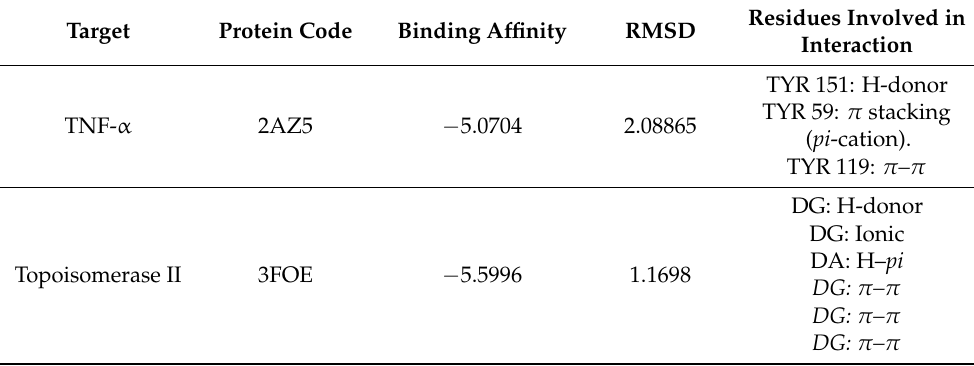
Table 1. Docking results of APAN at the target protein 2AZ5.